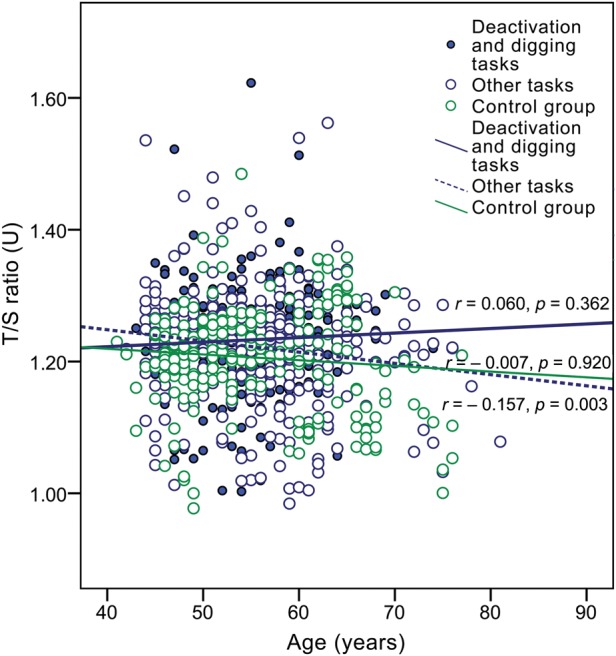
The effect of different types of job in Chernobyl on relative telomere length (T/S ratio) according to age in CNPP accident recovery workers compared with controls (Spearman's correlation coefficient r, P-value and trend lines indicated for each group).